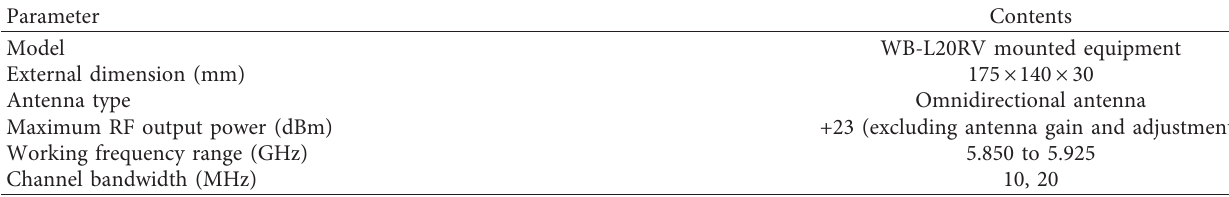
Table 1: Some OBU parameters for DSRC.